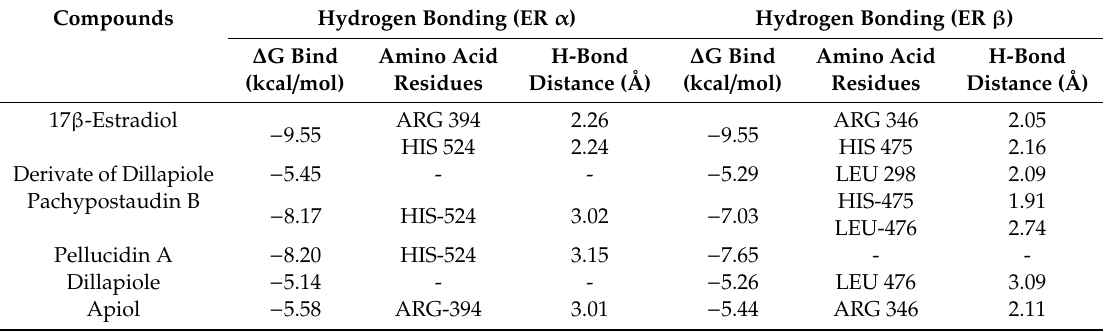
Table 3. Molecular docking data for binding of estradiol and five isolated compounds of P. pellucida to estrogen